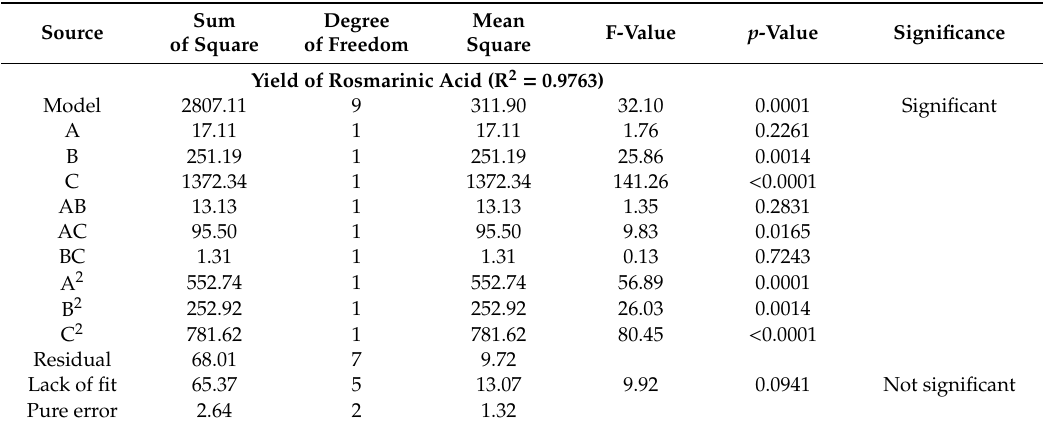
Table 2. Analysis of variance (ANOVA) for the yield of rosmarinic acid (RA). A: extraction time, B: amplitude, C: ethanol